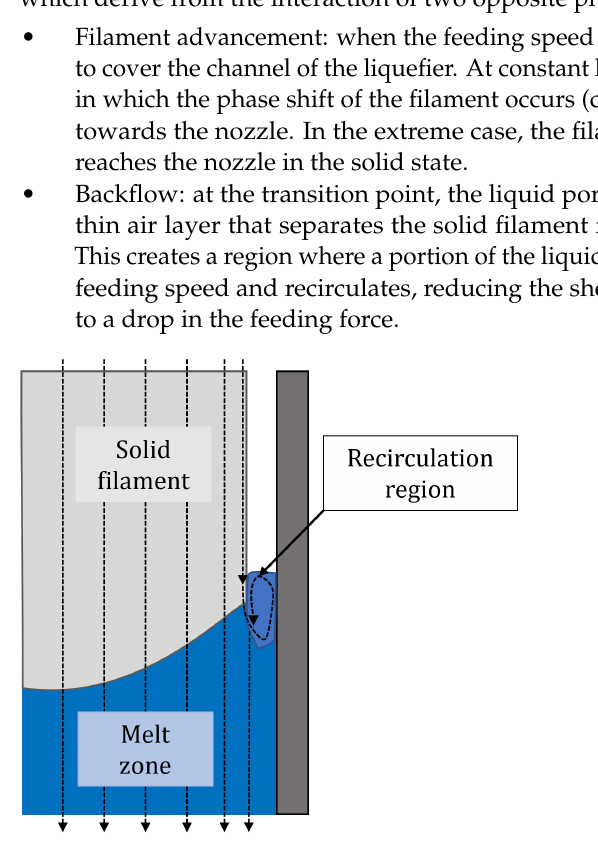
Figure 3. Example of the backflow phenomenon that occurs in the recirculating